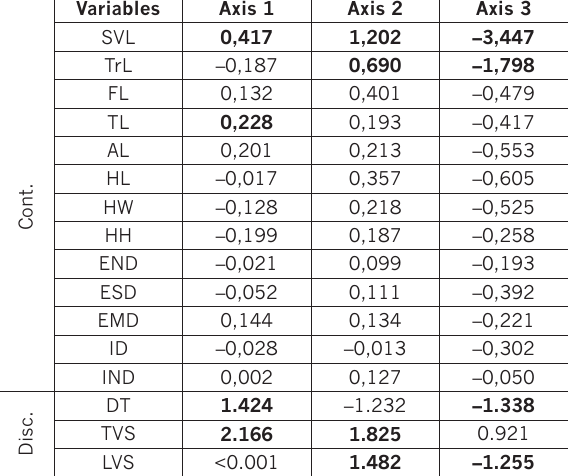
Table 3. Most contributing continuous (Cont.) and discrete (Disc.) variables (highlighted in bold) for Axis 1–3 of the